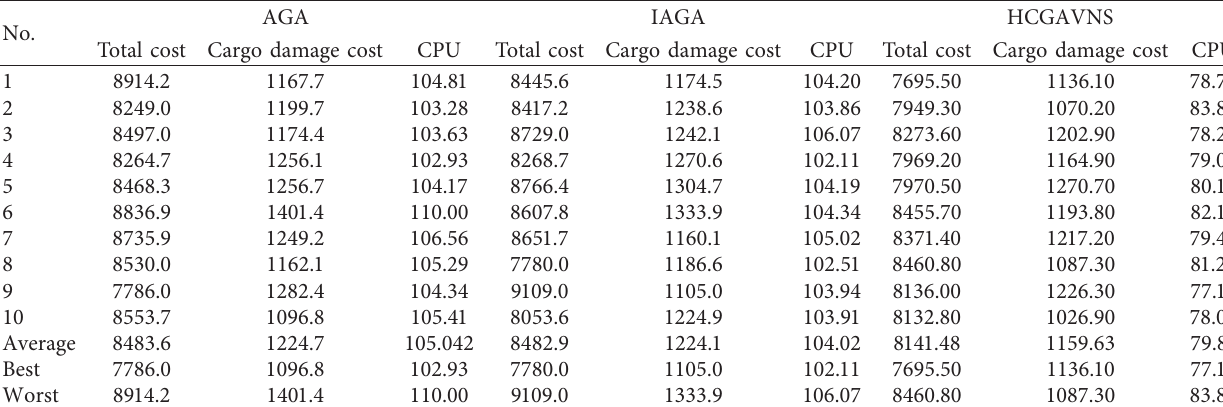
Table 9: Comparison of the three